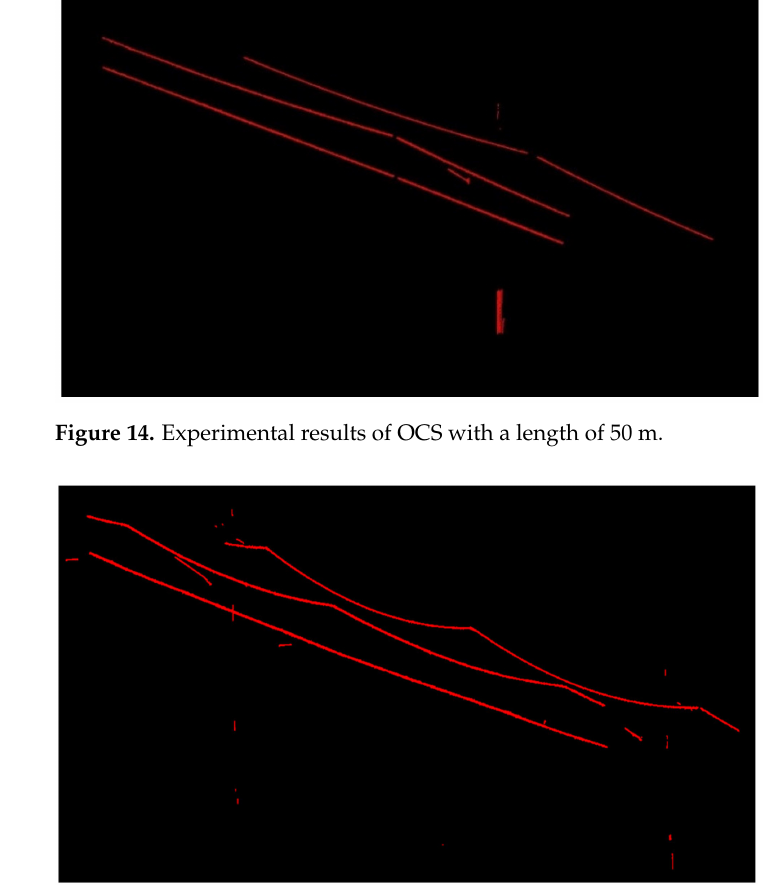
Figure 15. Experimental results of OCS with a length of 100